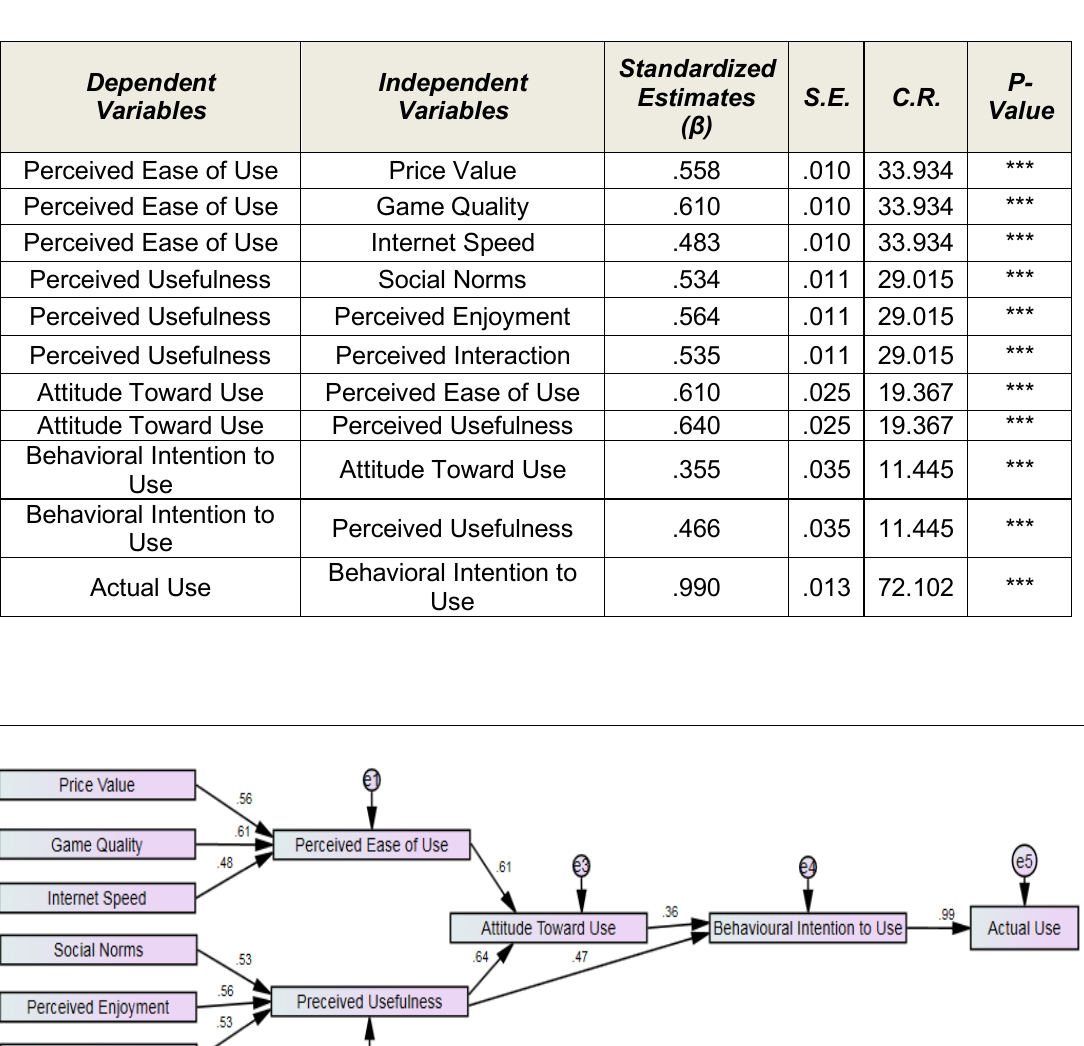
Table 3: Regression Weights